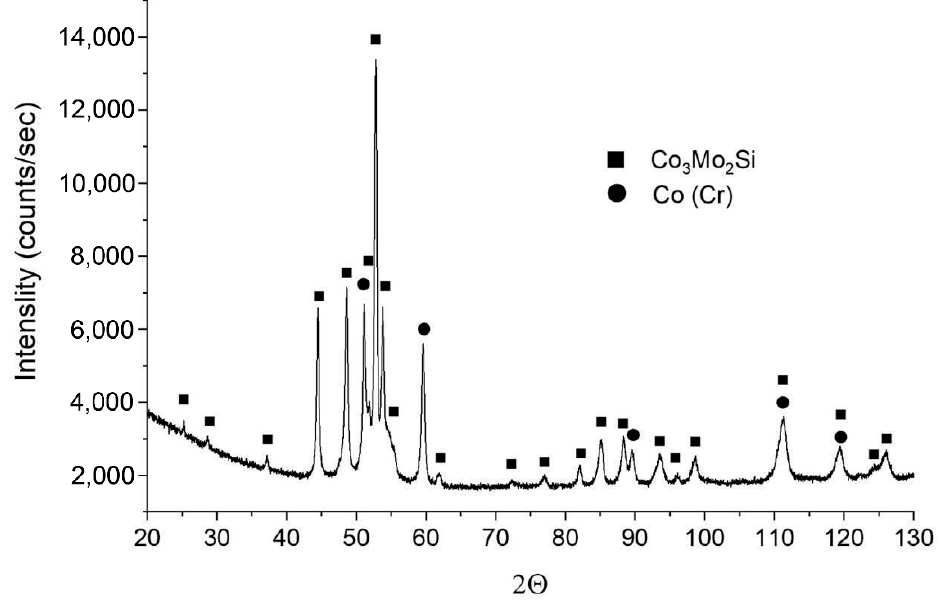
Figure 7. XRD patterns of the T-800 coatings obtained using the LENS technique.